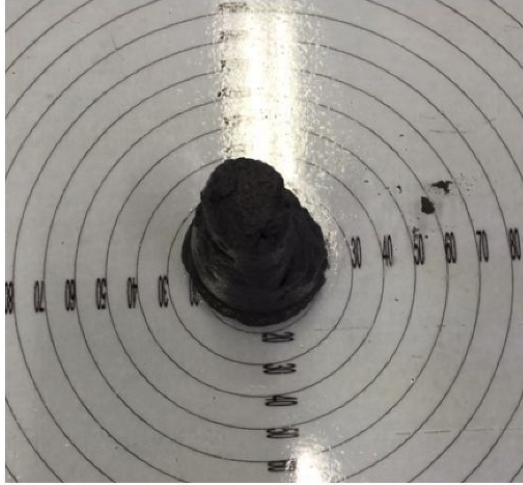
Figure 3. SF paste after the Kantros’s miniature slump test 30 , produced with the highest w/f ratio (w/f = 1.0) and superplasticizer content